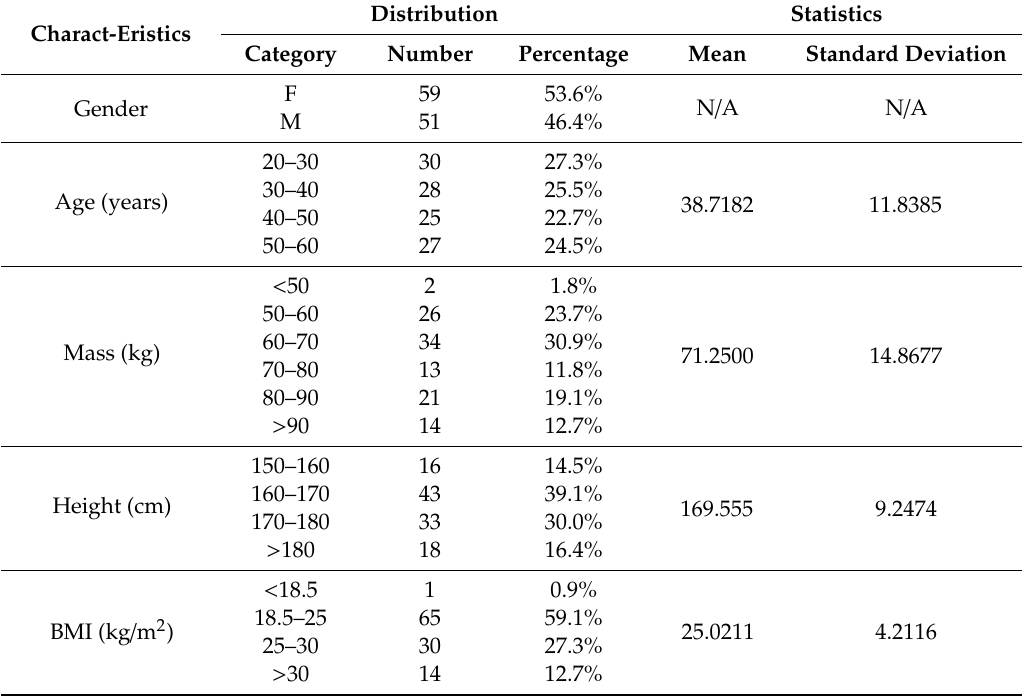
Table 1. Subject